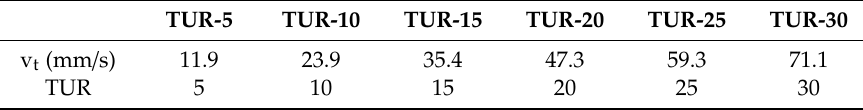
Table 2. The processing parameters of blown films ( v t is the taking up